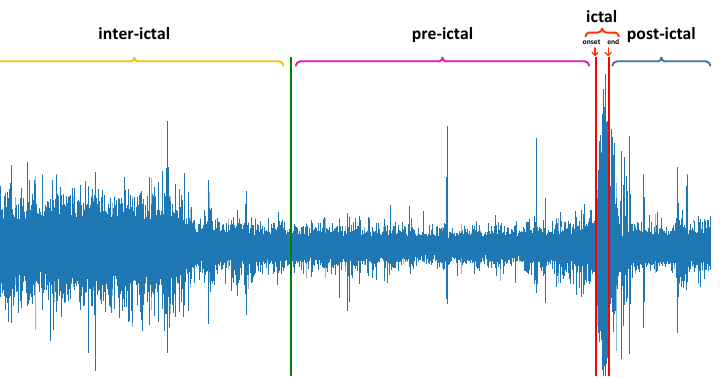
Figure 1. The state of the epileptic seizure. Inter-ictal, pre-ictal, ictal, and post-ictal state. This signal segment comes from channel FP1-F7 of chb01_03.edf file of case chb01 in the CHB-MIT Scalp EEG database. It contains a 15-min inter-ictal period, a 15-min pre-ictal period, a 40-s ictal period, and a 5-min post-ictal